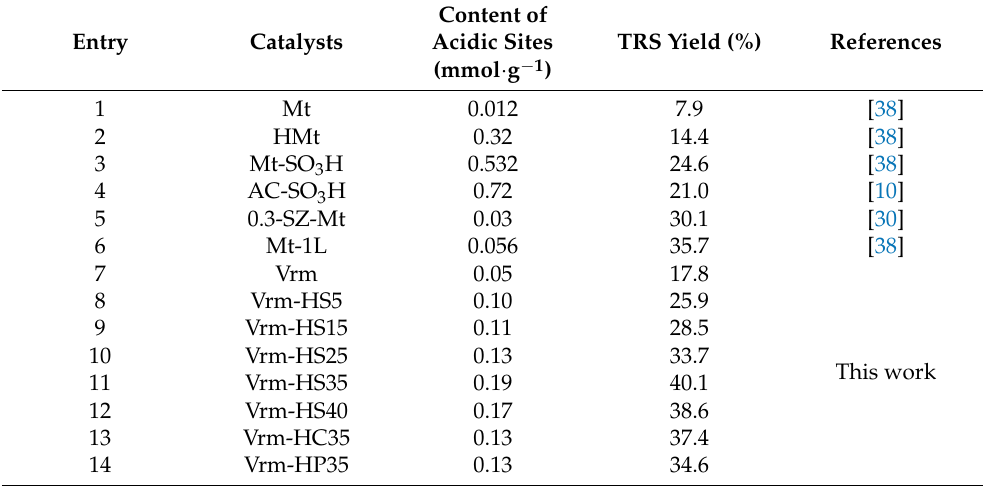
Table 1. The catalytic results of vermiculite and others reported catalysts for the cellulose hydrolysis a . Entry Catalysts